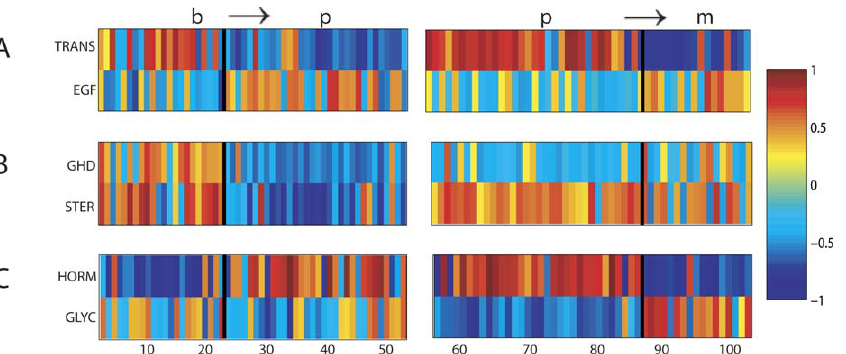
Figure 1. Pathways Relevant to Progression